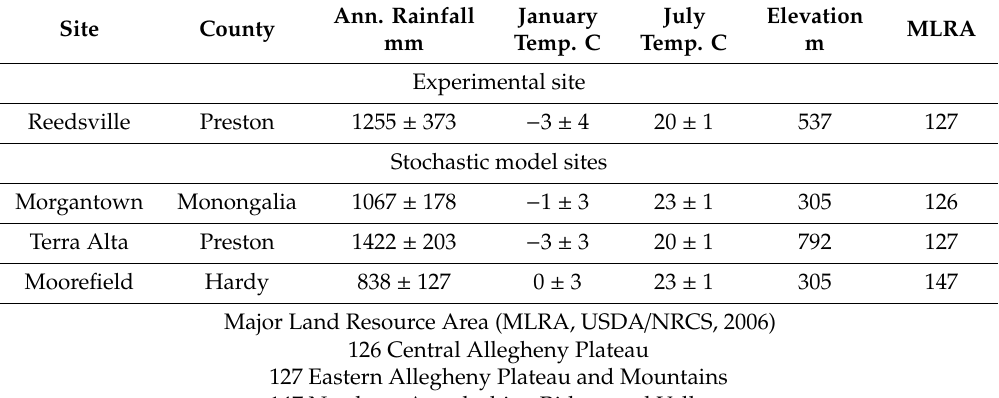
Table 5. Climatic description (Mean ± SD), elevation and location for the two experiments and the three sites, evaluated stochastically for pasture